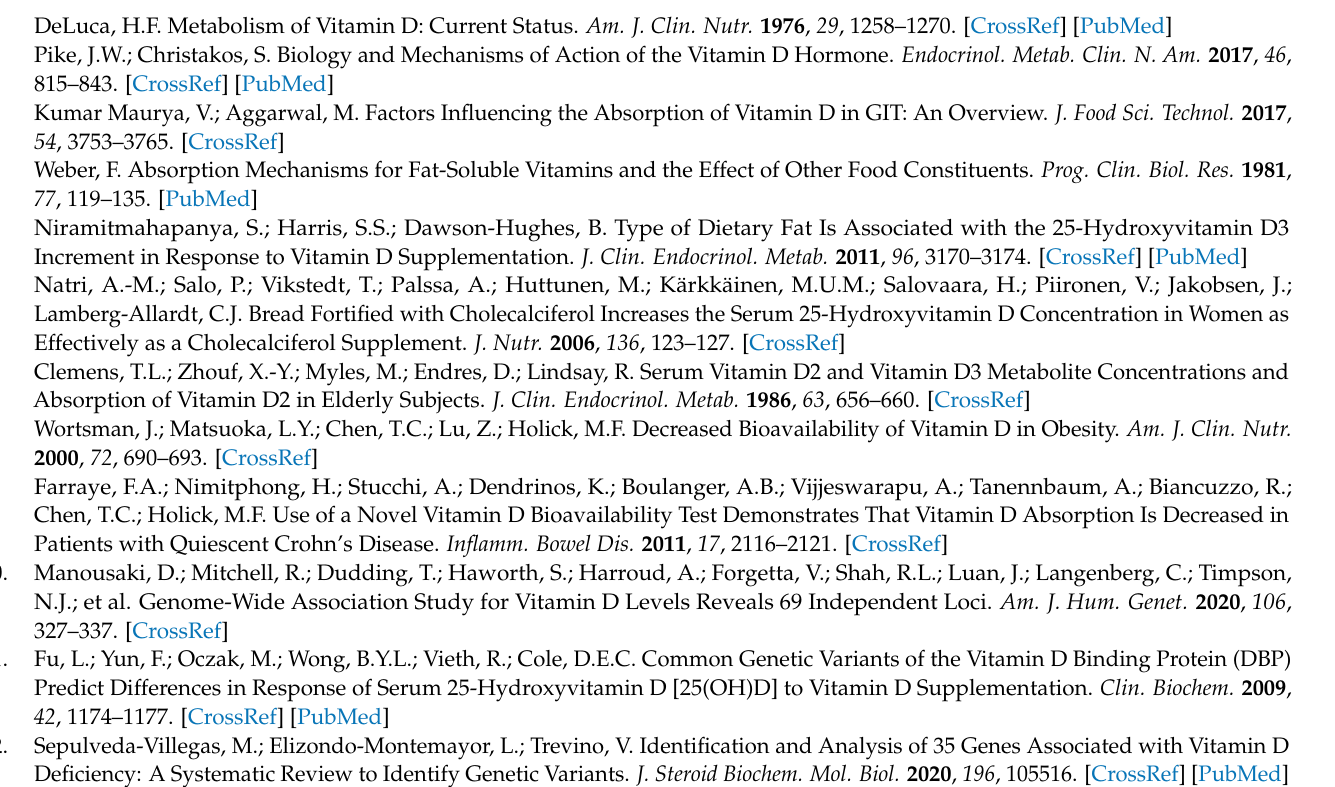
Figure S7: Vitamin D deficiency gene-disease network; Figure S8: Vitamin D deficiency gene-disease heat map; Figure S9: COVID-19 gene-disease network; Figure S10: COVID-19 gene-disease heat map; Figure S11: Enrichment analysis of VD deficiency and the VDR gene; Table S1: Genes and variants associated with COVID-19; Table S2: GWAS catalog of vitamin D deficiency; Table S3: GWAS catalog of